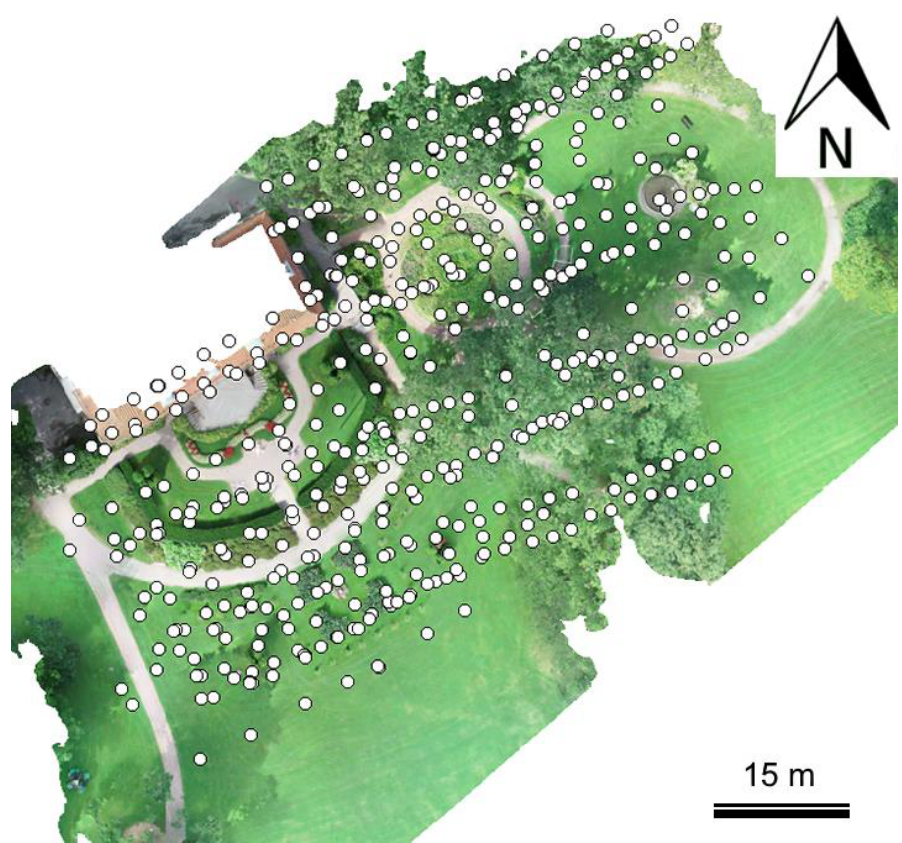
Figure 2. DJI Phantom 4 Pro+ survey flights. Camera stations are illustrated in white.